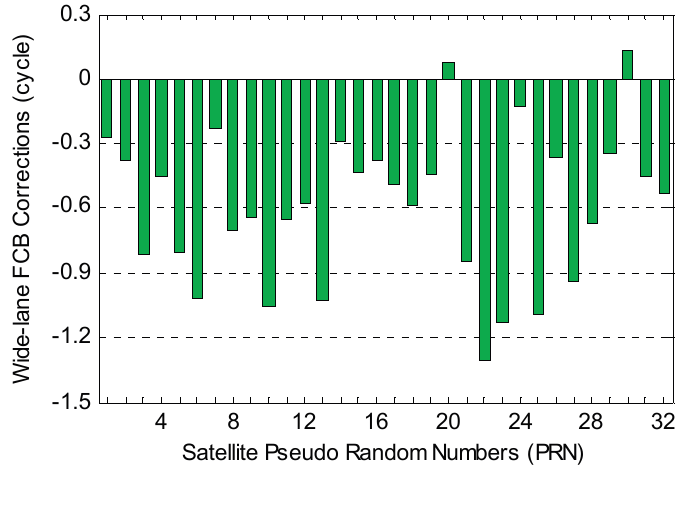
Figure 4. GPS wide-lane FCB corrections on the satellite end on 1 February